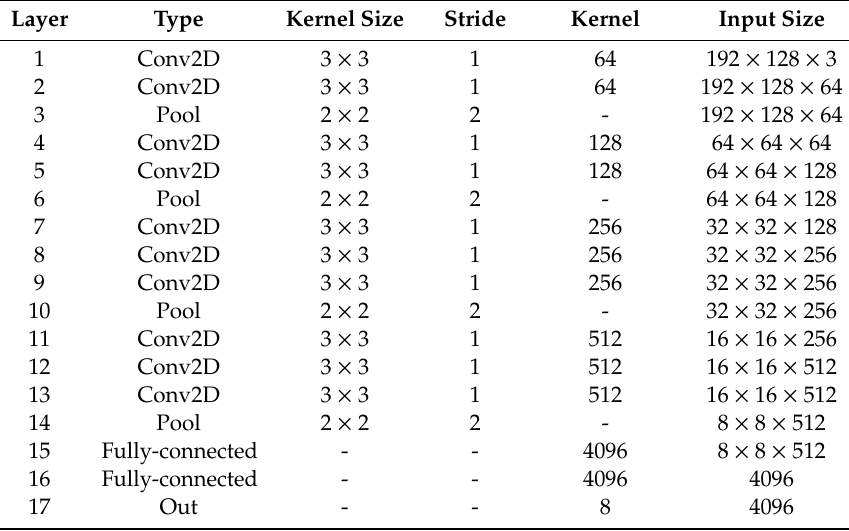
Table 3. Detailed overview of the VGGNet [27]